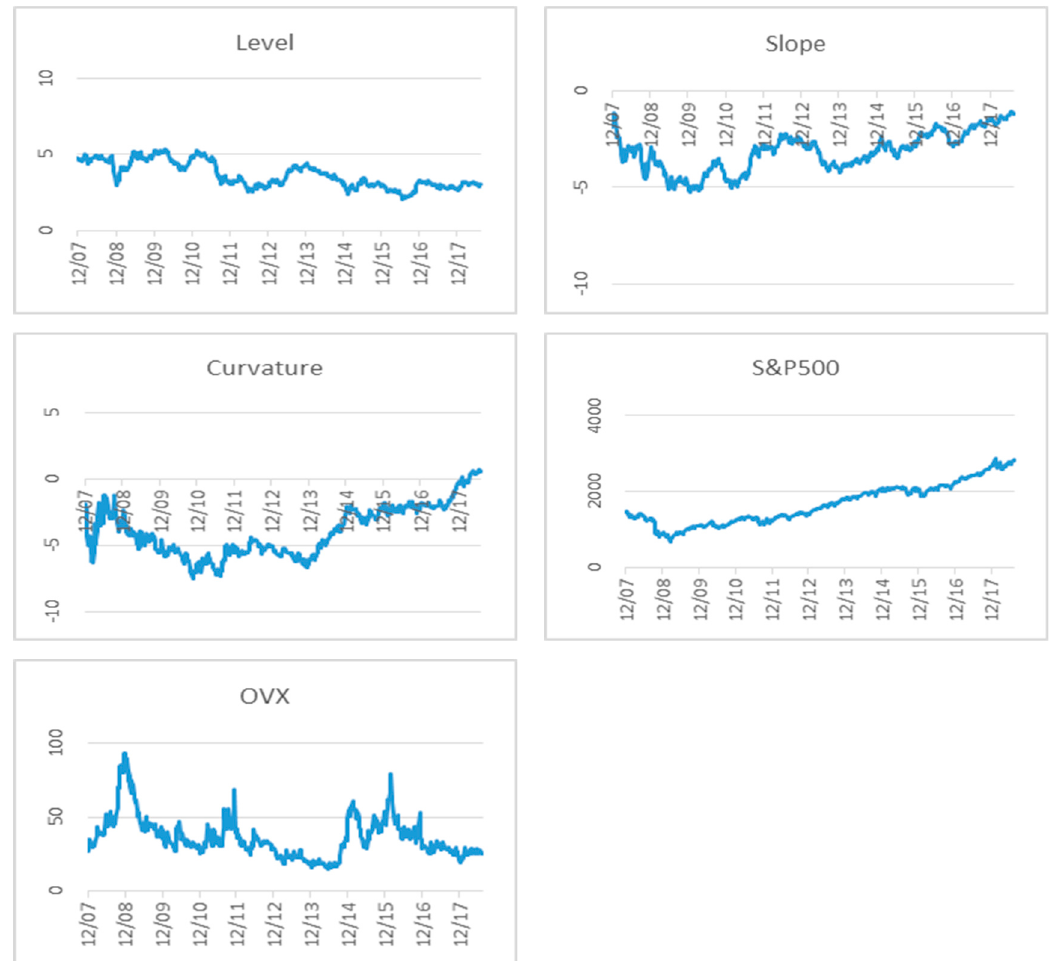
Figure 2. Time trends of the U.S. weekly yield curve factors, market index S&P 500 and volatility index OVX for the period December 2007 to August 2018.